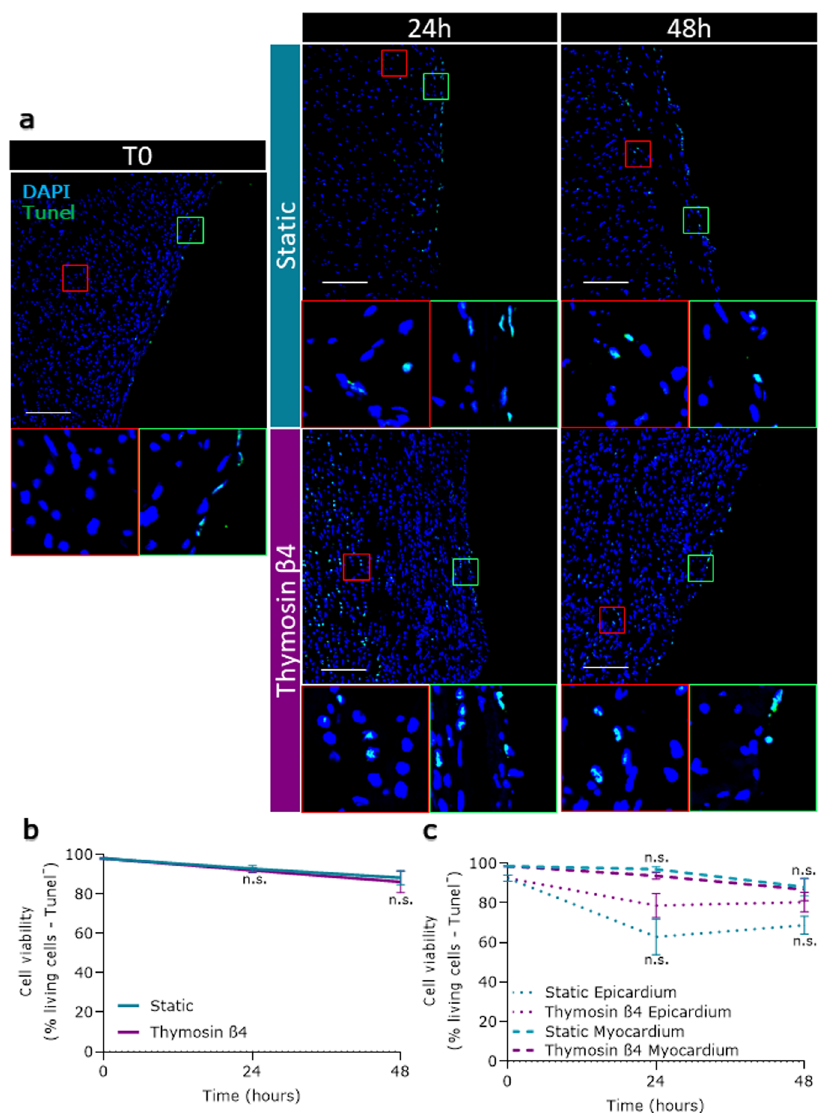
Fig. 8 Apoptosis is unaffected by T β 4 treatment. Apoptotic cells were evaluated by ApopTag detection kit assay ( a ); graphs report the fraction of non-apoptotic cells as a percentage of the total nuclei in the slice ( b ), and independently calculated fraction for myocardium and epicardium ( c ). N of pigs = 3 – 6, number of slices displayed in the graph. All graphs display data as mean ± SEM. n.s. not signi fi cant vs. Static control. Scale bar, 100